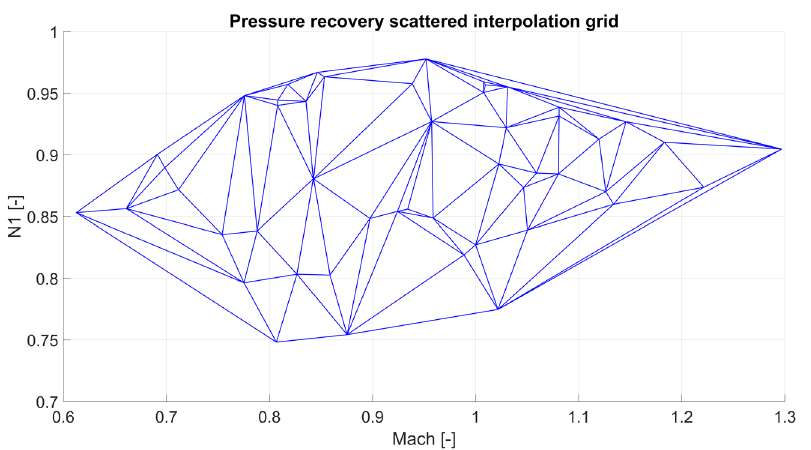
Figure 6. Example of pressure recovery interpolation grid.